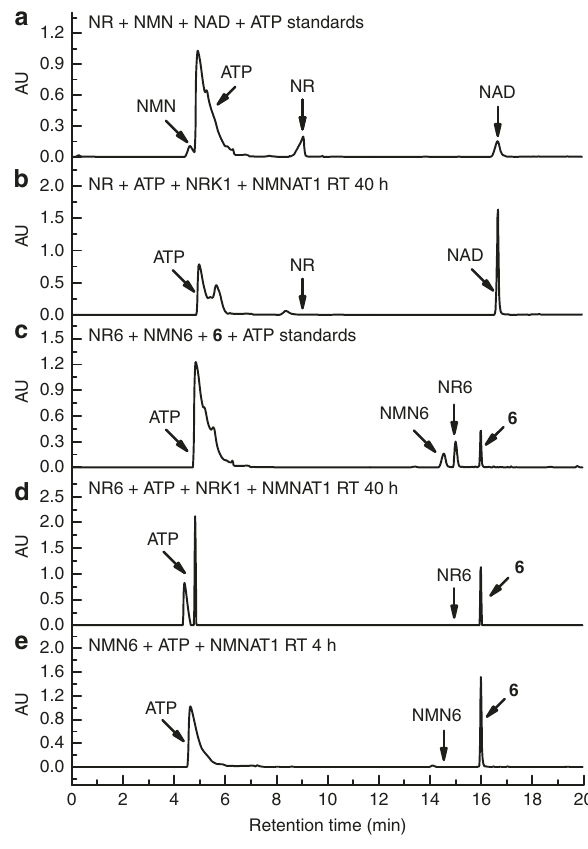
Fig. 2 HPLC analysis of enzymatic formation of NAD + and 6 . a Assigned peaks for standard compounds of NR, NMN, NAD + and ATP. b One millimolar NR was incubated with 5 mM ATP, 5 µ M NRK1, and 5 µ M NMNAT1 at RT for 40 h, followed by HPLC analysis. c Assigned peaks for standard compounds of NR6, NMN6, 6 and ATP. d One millimolar NR6 was incubated with 5 mM ATP, 5 µ M NRK1, and 5 µ M NMNAT1 at RT for 40 h, followed by HPLC analysis. e One millimolar NMN6 was incubated with 5 mM ATP, 5 µ M NRK1, and 5 µ M NMNAT1 at RT for 4 h, followed by